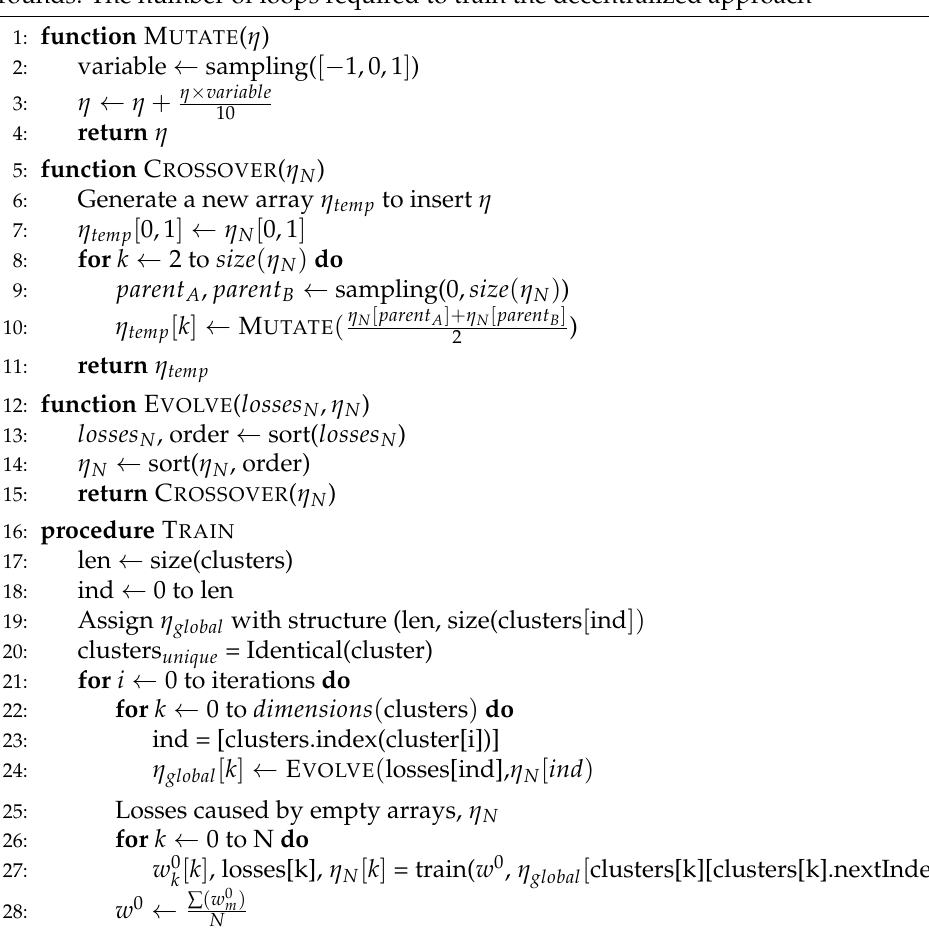
Algorithm 2 FL-based genetic optimization for clustered